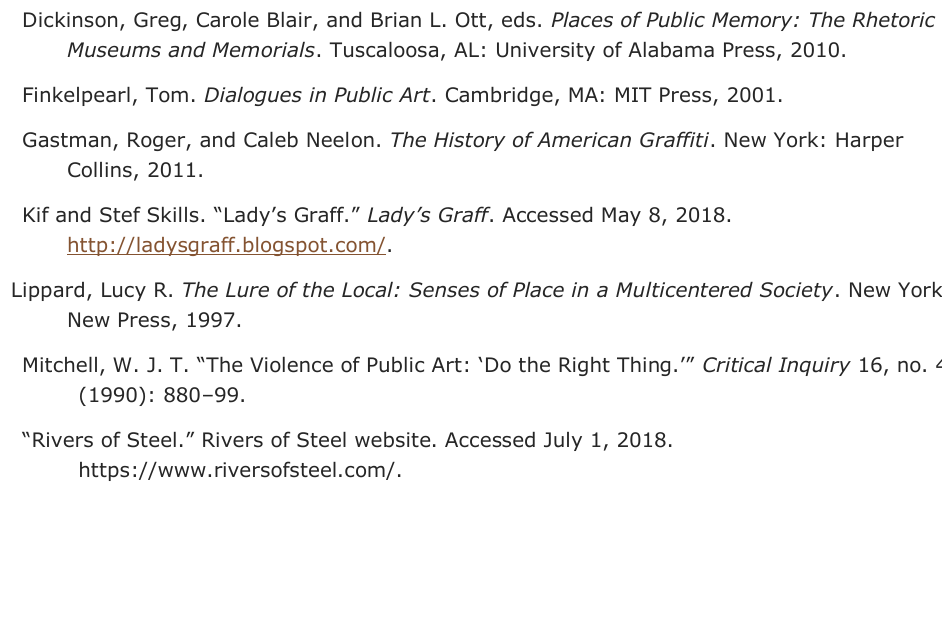
Contemporaneity: Historical Presence in Visual Culture http://contemporaneity.pitt.edu Vol 7, No 1 (2018) | ISSN 2153-5194 (online) | DOI